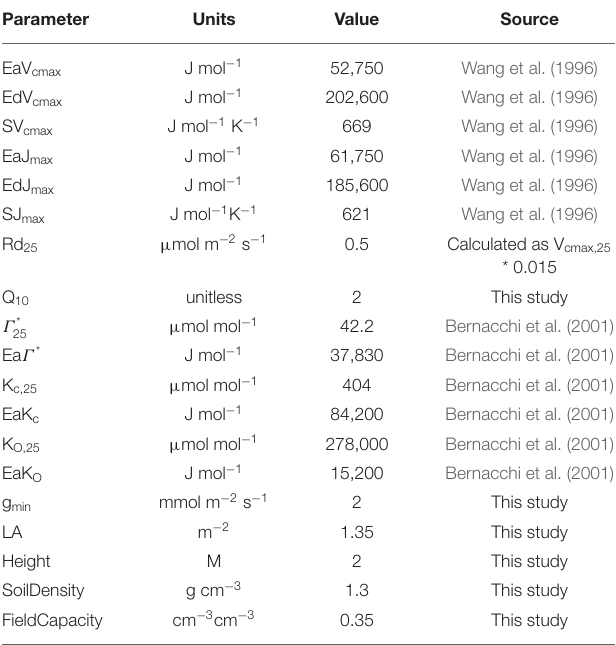
TABLE 1 | Fixed, not previously calibrated parameters used in the SOX +